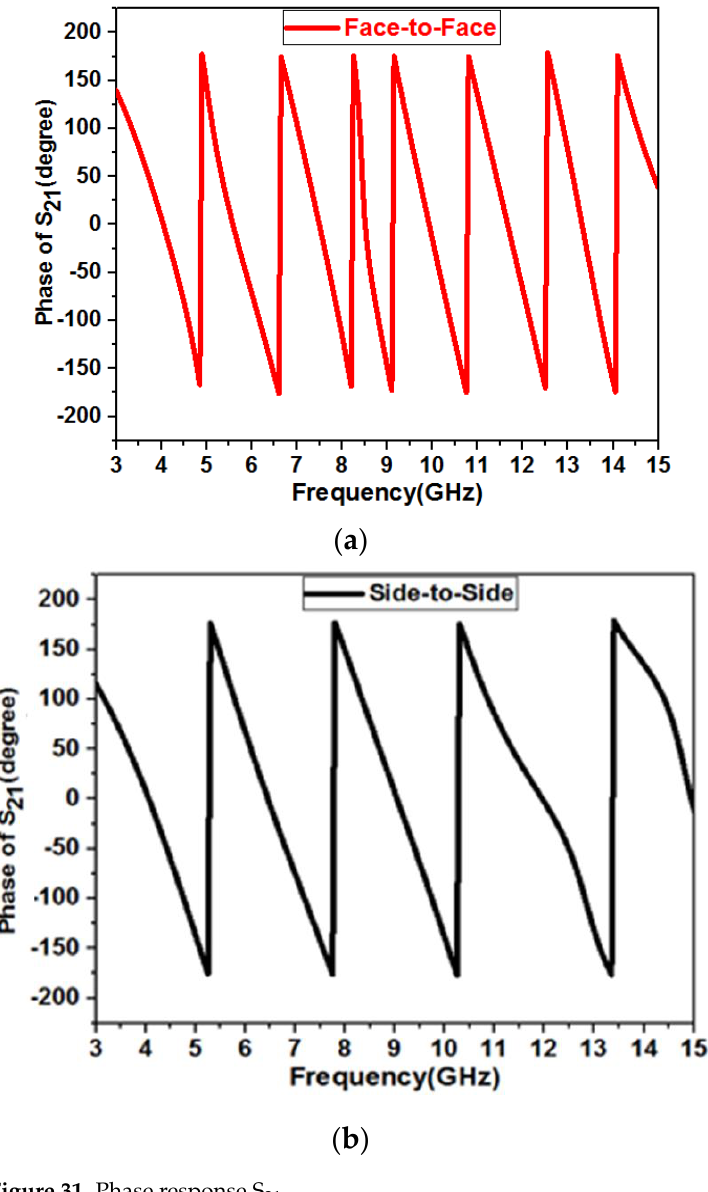
Figure 31. Phase response S 21.